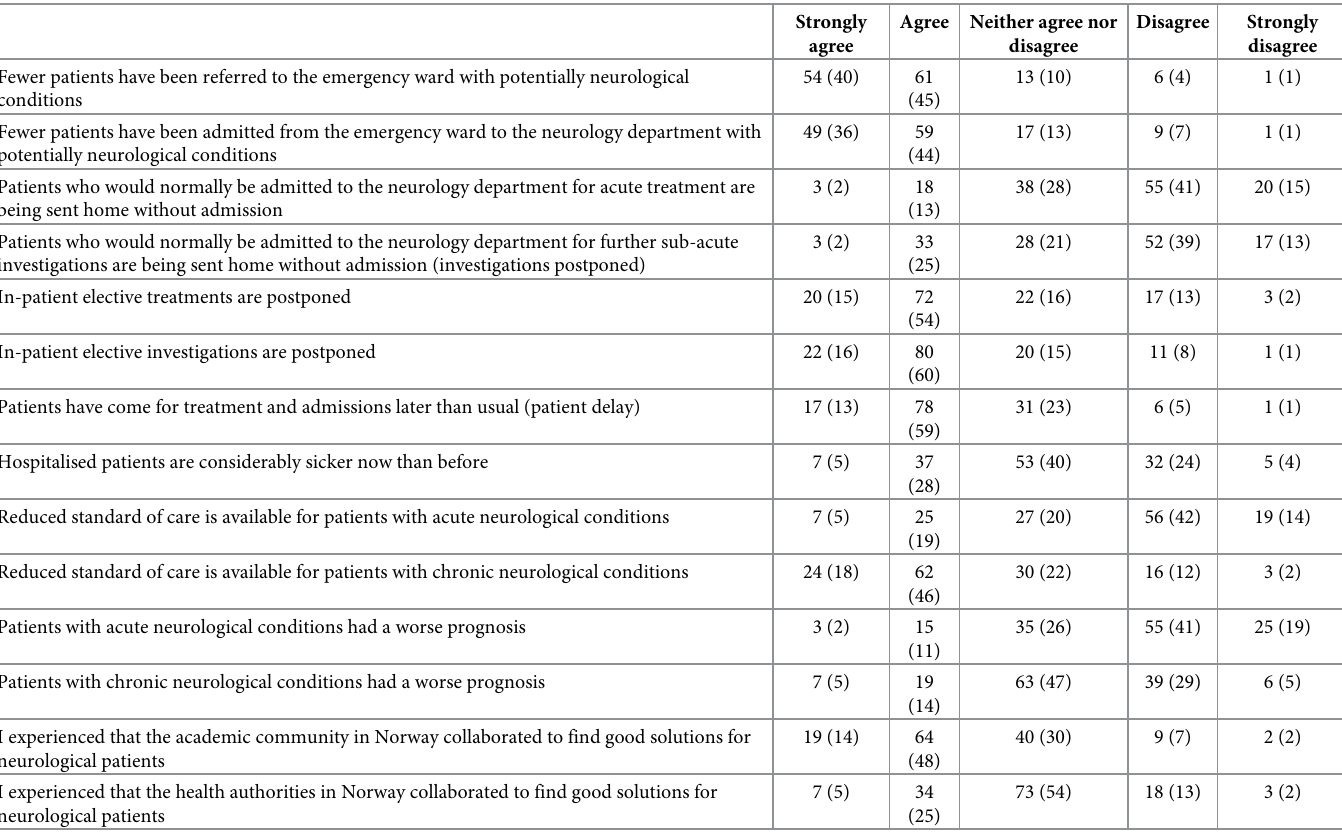
Table 3. Please rate the following statements, n (%).